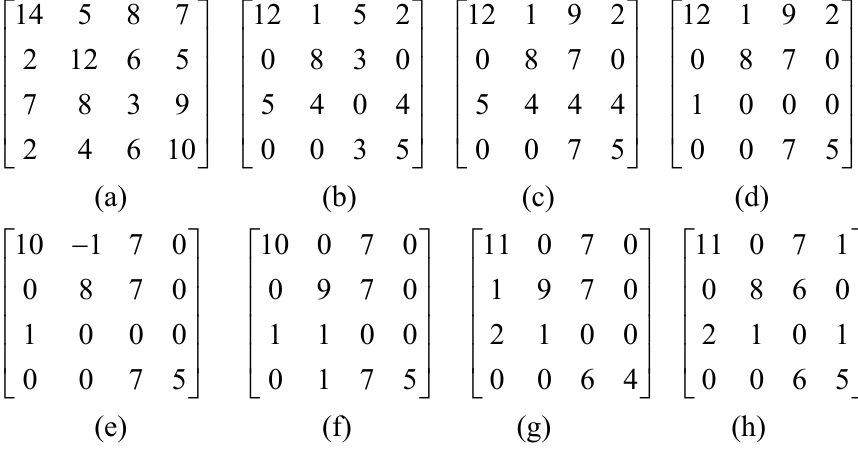
Table 1. For the second scenario, the target topology shape is a cube with a side length